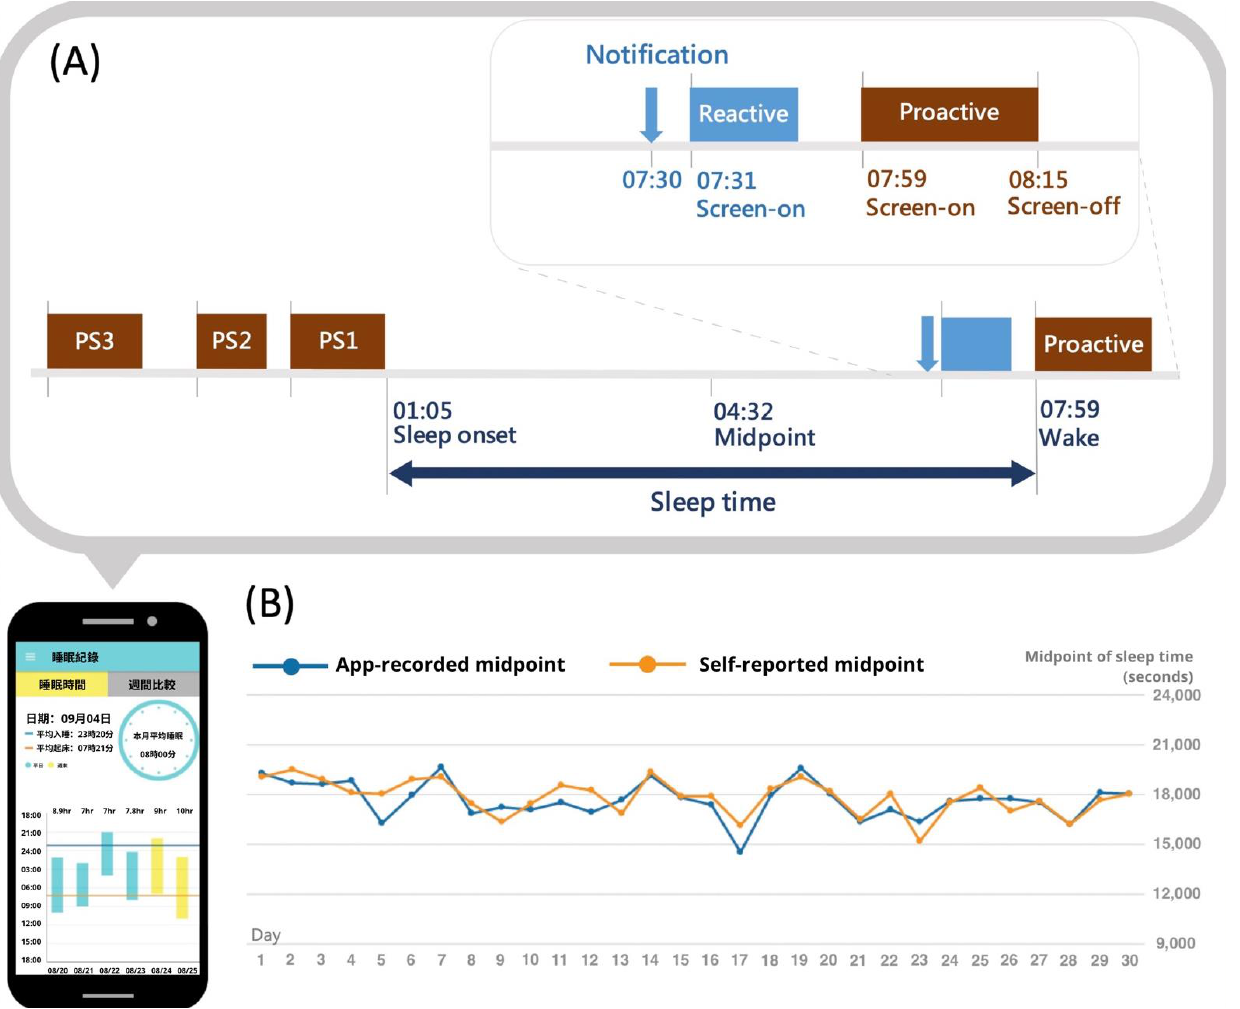
Figure 4. ( A ) Smartphone use from screen-on to the successive screen-off was defined as one episode of use. Usage episodes without notifications during the one minute before screen-on were classified as proactive use, whereas episodes with notification during the one minute before screen-on were classified as reactive use. Only proactive use episodes were included in the calculation of sleep time. ( B ) Daily app-recorded and self-reported midpoints of sleep time were compared to validate the fluctuations in circadian rhythms. The figure showed a high agreement between app-recorded and self-reported midpoints of sleep